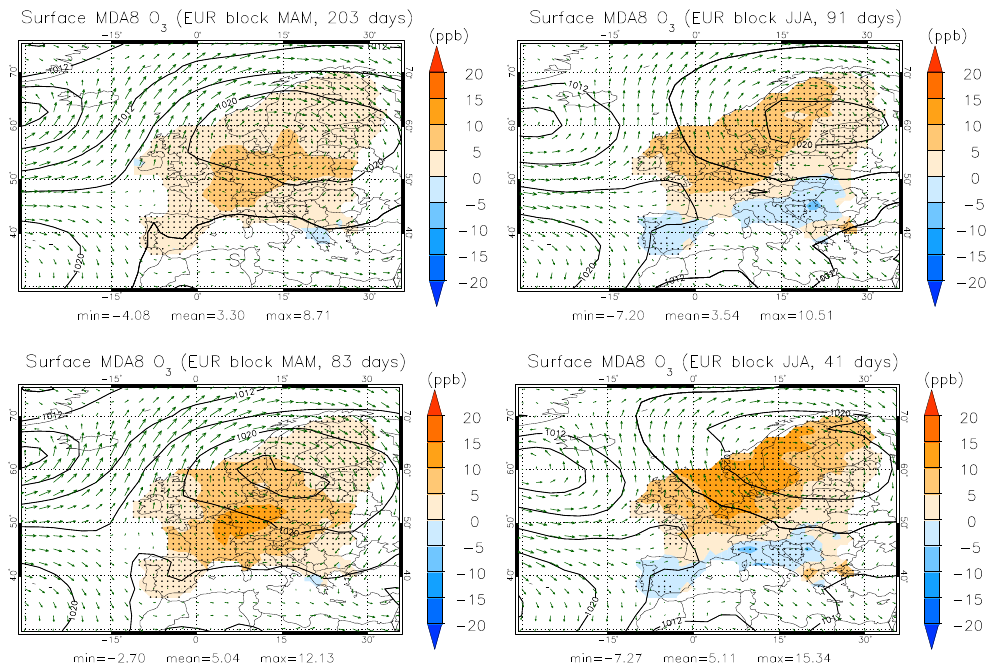
Figure 4. Composites of the seasonal anomalies of surface MDA8 O 3 (ppb) for days with blocking centres over the European sector (EUR, 0–30 ◦ E) during spring (left) and summer (right). Anomalies have been calculated with respect to the MDA8 O 3 mixing ratios on days without EUR blocking in that season during the 1998–2012 period. All data on days with blocking centres remaining over 0–30 ◦ E (top) and data only from the third day with blocks in that sector (bottom) have been taken into account for the calculation of the ozone anomalies. Stippling indicates statistically significant anomalies at the 5% level (two-sided t test). The black contour lines depict the composites of MSLP (hPa) for those days. Horizontal wind fields at 850hPa are displayed by arrows. The total number of days considered is indicated on the top of each